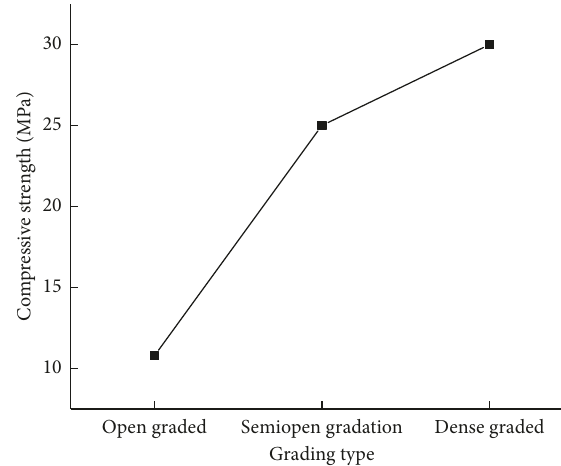
Figure 14: Relationship between grading type and strength.